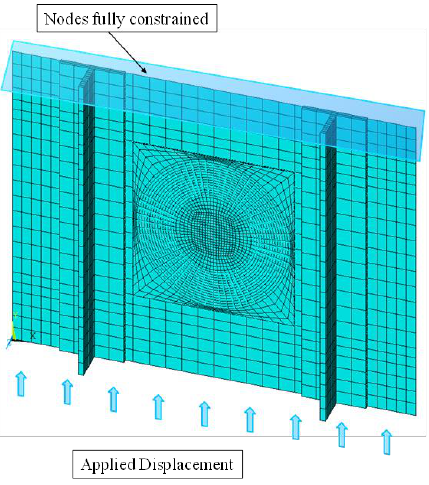
Figure 4. Load condition. Figure 4. Load